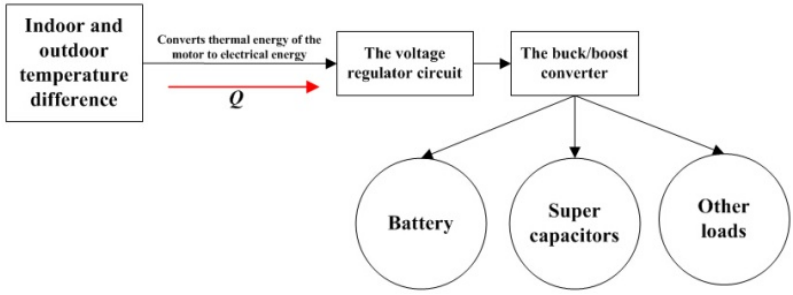
Figure 2. Control diagram of TE Board power generation system.